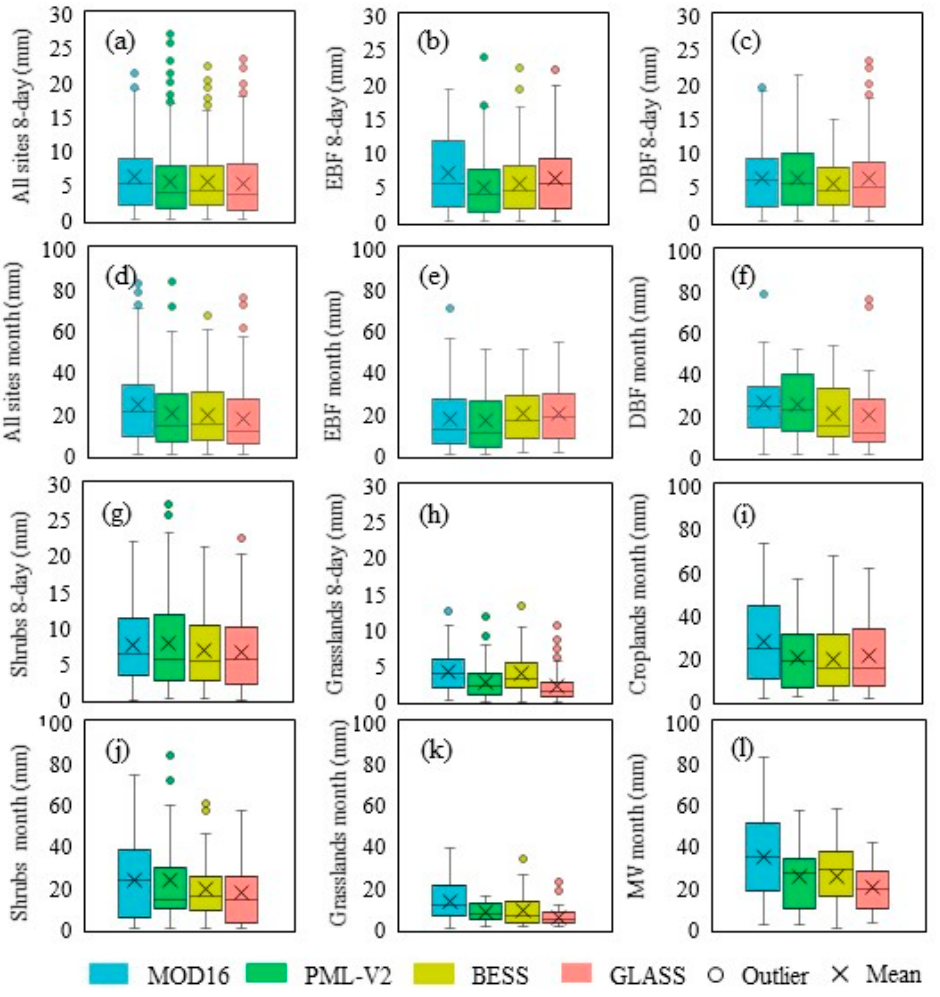
Figure 3. Boxplots of mean absolute error (MAE) for all four ET products and EC ET in 8-day ( a – c , g , h ) and monthly ( d – f , i – l ) scales. Table 4. Multiple comparison test of the four ET products using the mean absolute error of all sites and various vegetation types.